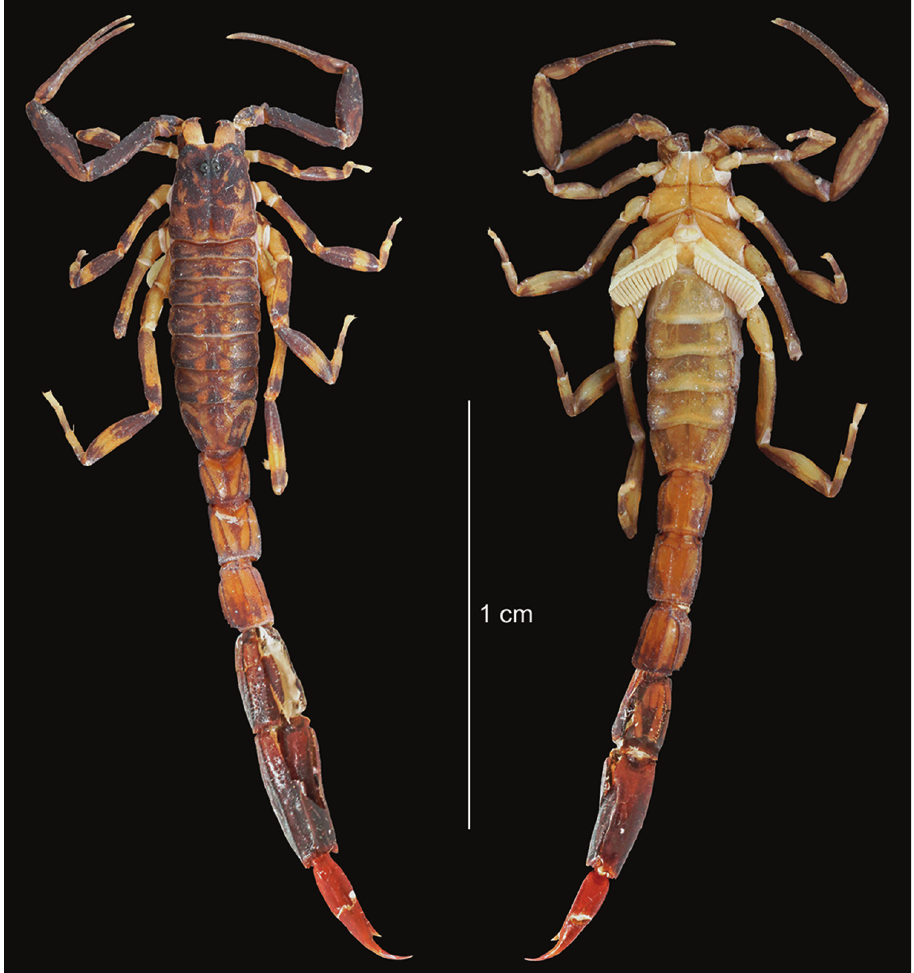
Figure 4. Ananteris kalina sp. n., male holotype from Mana. Habitus, dorsal and ventral aspect. and posterior median carinae weak or absent; all furrows moderate to weak; median ocular tubercle distinctly anterior to the center of carapace; median eyes separated by approximately half of one ocular diameter; three pairs of reduced lateral eyes. Tergites with moderately to strongly marked granulation, similar to that of carapace; median carina moderately to weakly marked on all tergites, better marked posteriorly; tergite VII pentacarinate. Sternum subpentagonal. Pectines rather longs; pectinal tooth count 16–17 in male holotype (17–17 in male paratype); basal middle lamellae of pectines not dilated; fulcra absent. Sternites almost smooth, only VI and VII slightly granular; spira- cles rather short, semi-oval; setation moderate; sternite VII with vestigial carinae; genital operculum divided longitudinally, each plate more or less suboval in shape. Metasomal segments with 10-8-8-8-5 weakly crenulate carinae; intercarinal spaces moderately